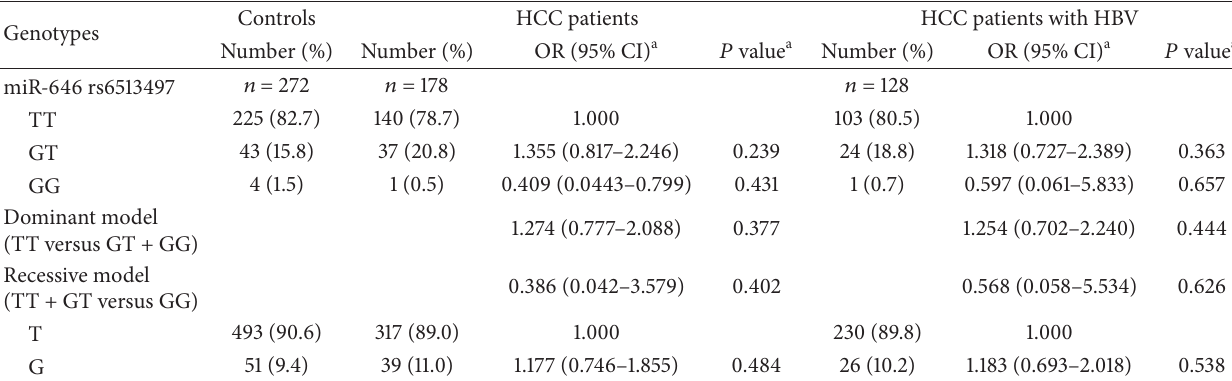
Table 4: Comparison of genotype/allele frequencies of miR-646 rs6513497 in female